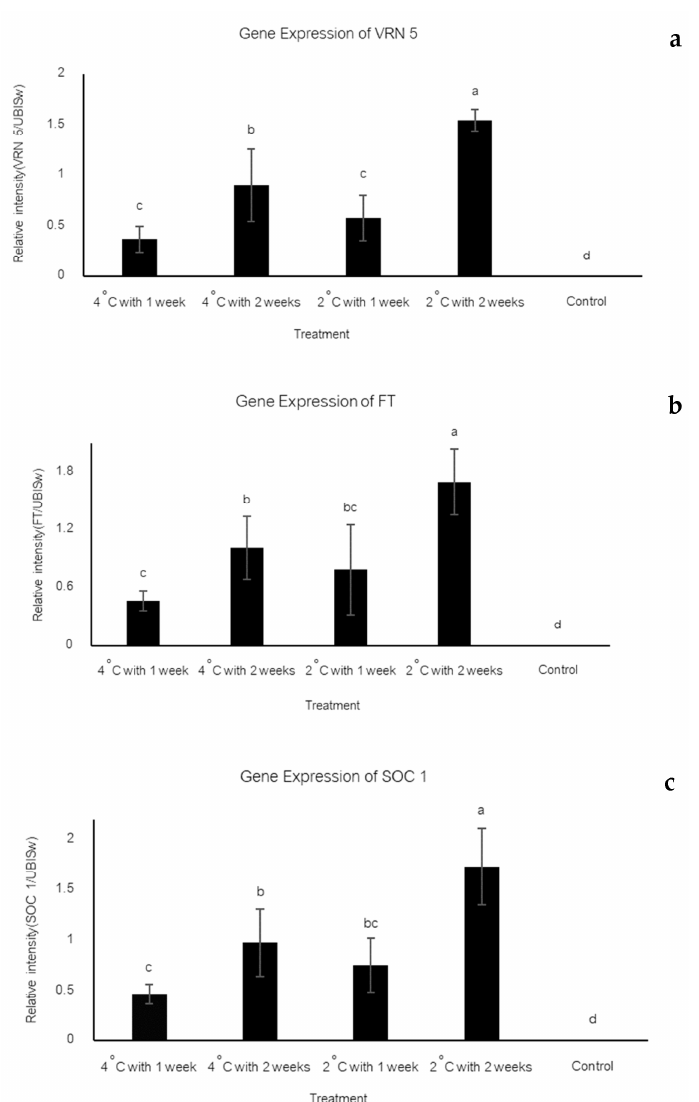
Figure 3. Relative expression level of flowering gene expression in strawberry cv. Pharachatan 80 after vernalization. Relative intensity was determined in comparison with that of UBISw reference. ( a ) The relative intensity of VRN5/UBISw, ( b ) the relative intensity of SOC1/UBISw and ( c ) the relative intensity of FT/UBISw.